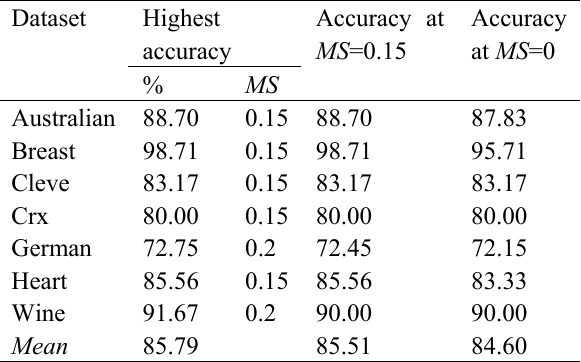
Table 12: Setting of MS vs. accuracy on CFAR